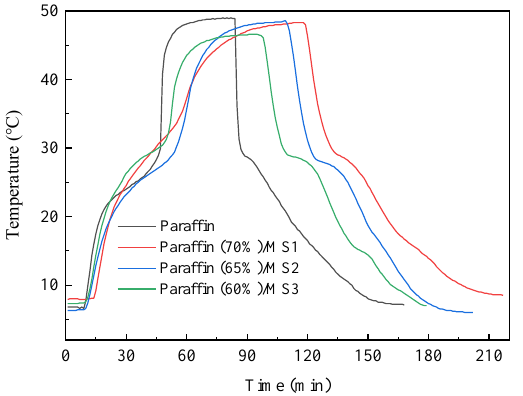
Figure 9. Temperature evolution of paraffin and paraffin/MS SS-PCMs with different MS pore diameters during the heat charging and discharging process.